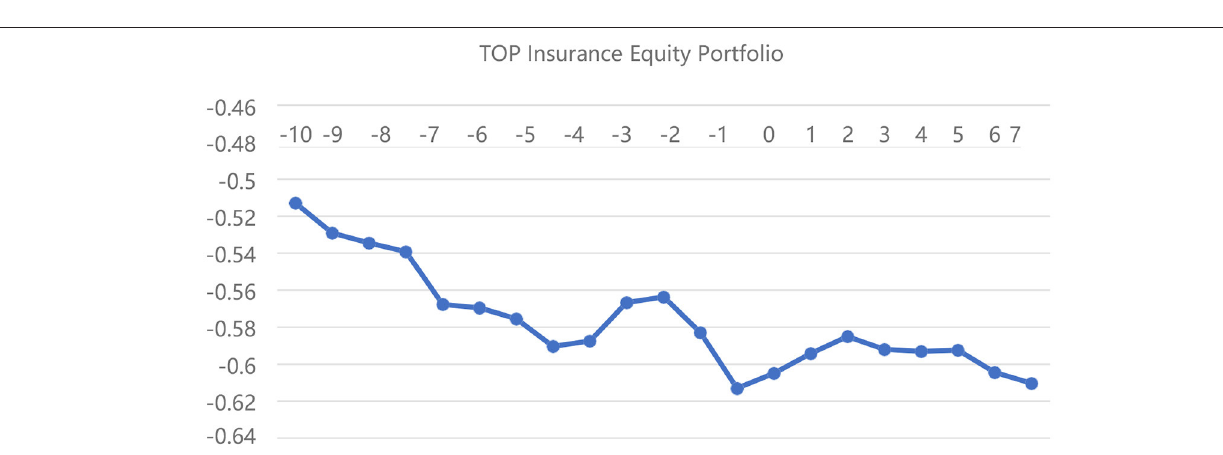
FIGURE 3 | Cumulative excess return of the TOP insurance equity portfolio on a line